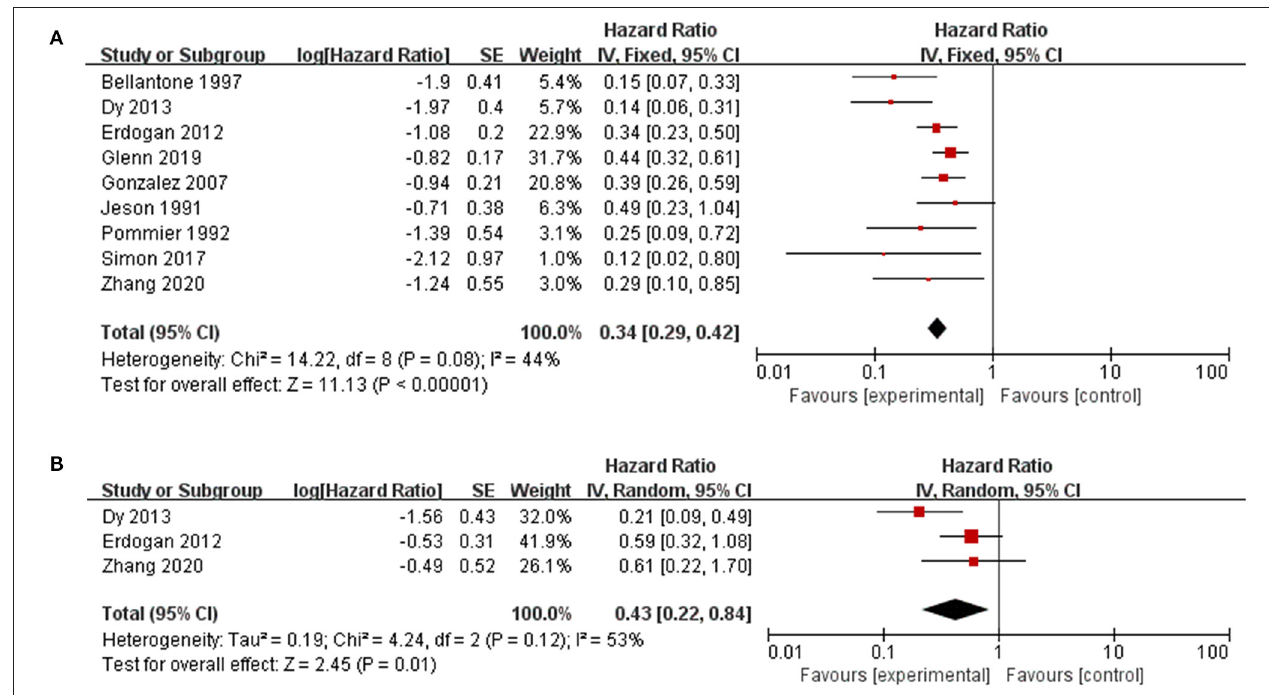
FIGURE 2 | Pooled results of reoperation for recurrent ACC. (A) reoperation vs. nonoperative management; (B) debulking or incomplete resection vs. nonoperative management.